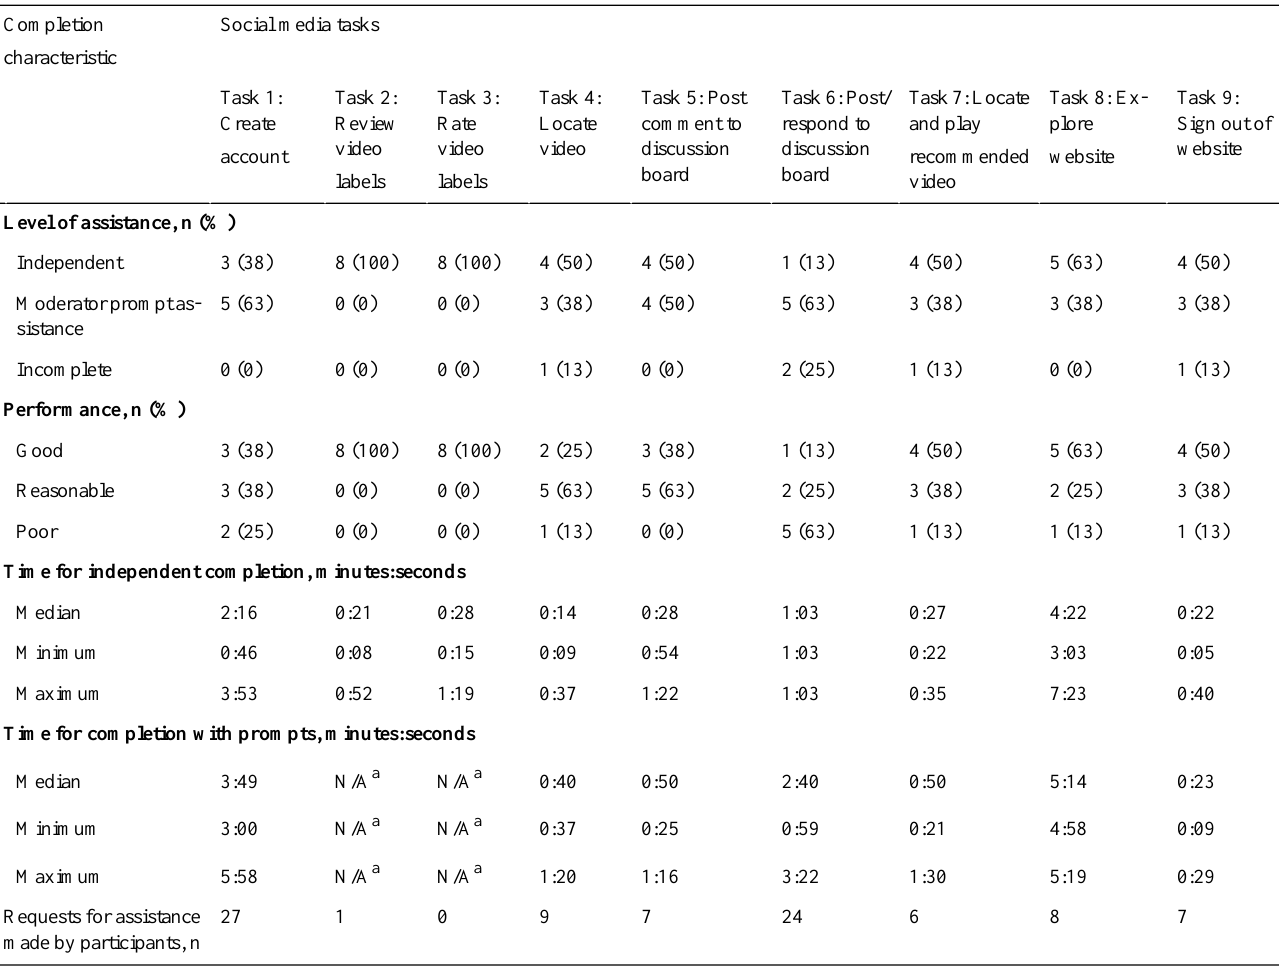
Table 3. Completion, performance, time needed, and number of requests for assistance during each social media task among think-aloud participants